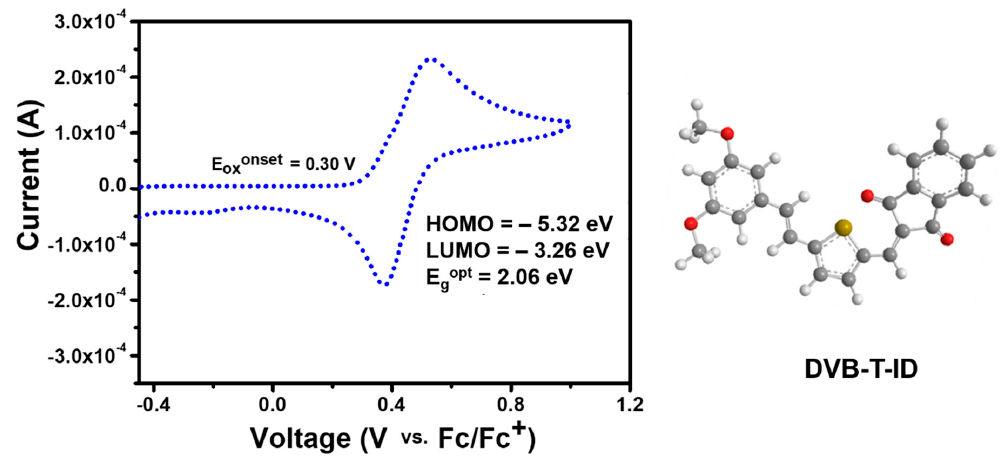
Figure 4. Cyclic voltammetry and molecular structure of a DVB-T-ID thin film in 0.1 M TBAPF 6 as the supporting electrolyte in an anhydrous acetonitrile solution, with ferrocene as an external